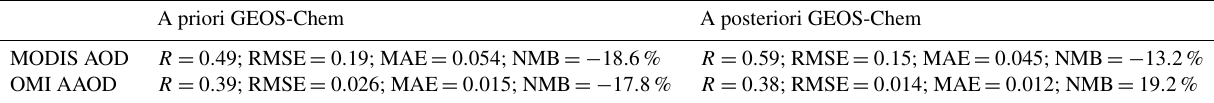
Table 4. Statistics for evaluation of a priori and a posteriori daily GEOS-Chem simulation with MODIS AOD and OMI AAOD in the year 2010.